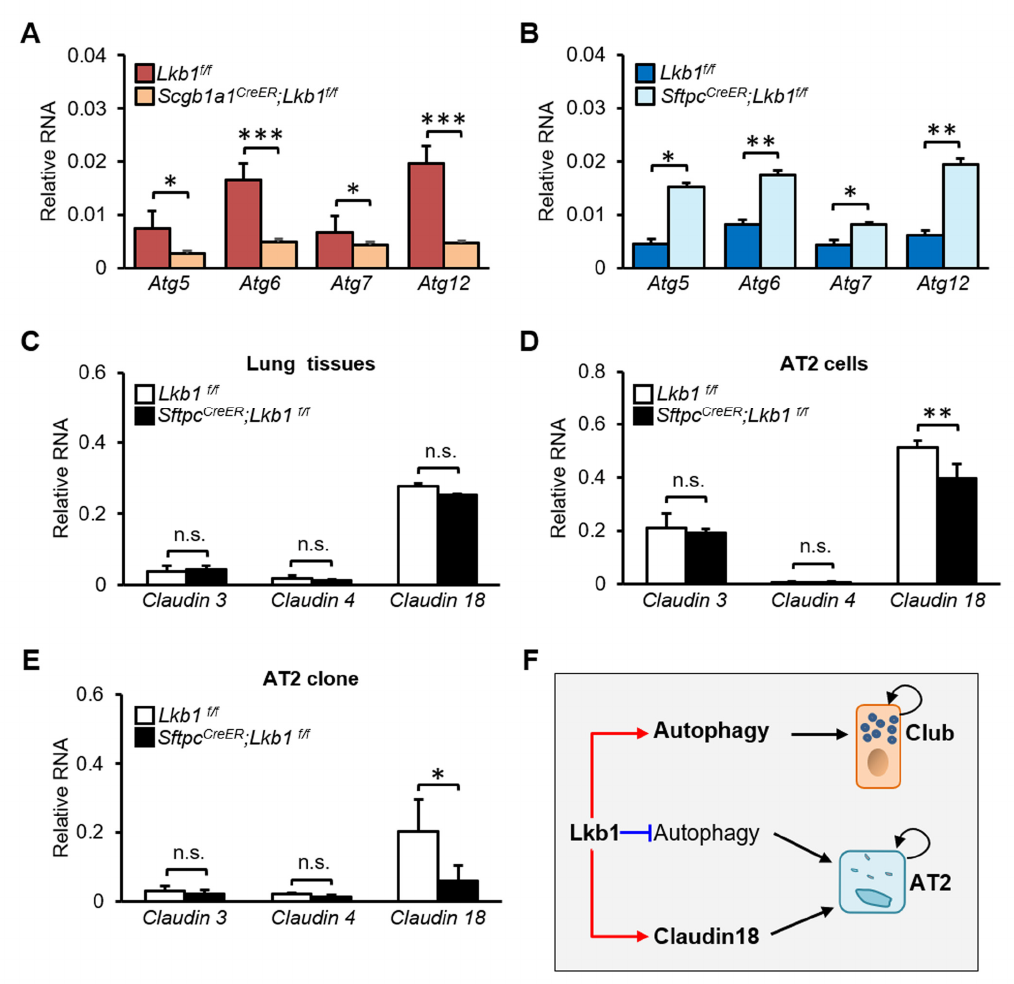
Figure 5. Possible role of autophagy and Claudin-18 in Lkb1 -mediated regulation of the proliferation of mouse lung epithelial progenitor cells. ( A ) qPCR analysis of the expression of Atg5 , Atg6 , Atg7 , and Atg12 in club cells isolated from Lkb1 f/f mice and Scgb1a1 CreER ; Lkb1 f/f mice (n = 7). ( B ) qPCR analysis of the expression of Atg5 , Atg6 , Atg7 , and Atg12 in AT2 cells isolated from Lkb1 f/f mice and Sftpc CreER ; Lkb1 f/f mice (n = 7). ( C – E ) qPCR analysis of Claudin 3 , Claudin 4 and Claudin 18 expression in lung tissues (C), AT2 cells (D), and organoid cultures of AT2 cells E) isolated from Lkb1 f/f mice and Sftpc CreER ; Lkb1 f/f mice (n = 6). ( F ) Schematic model describing the contribution of Lkb1 to the proliferation of lung epithelial progenitor cells. Data are representative of three independent experiments. All data are presented as means ± SD. * p < 0.05, ** p < 0.01, *** p < 0.001. In a similar analysis of alveolar epithelial AT2 cells, the levels of autophagy markers, including Atg5 (0.015 ± 0.006 ( Lkb1 KO) vs. 0.005 ± 0.002 (Control), p = 0.017),